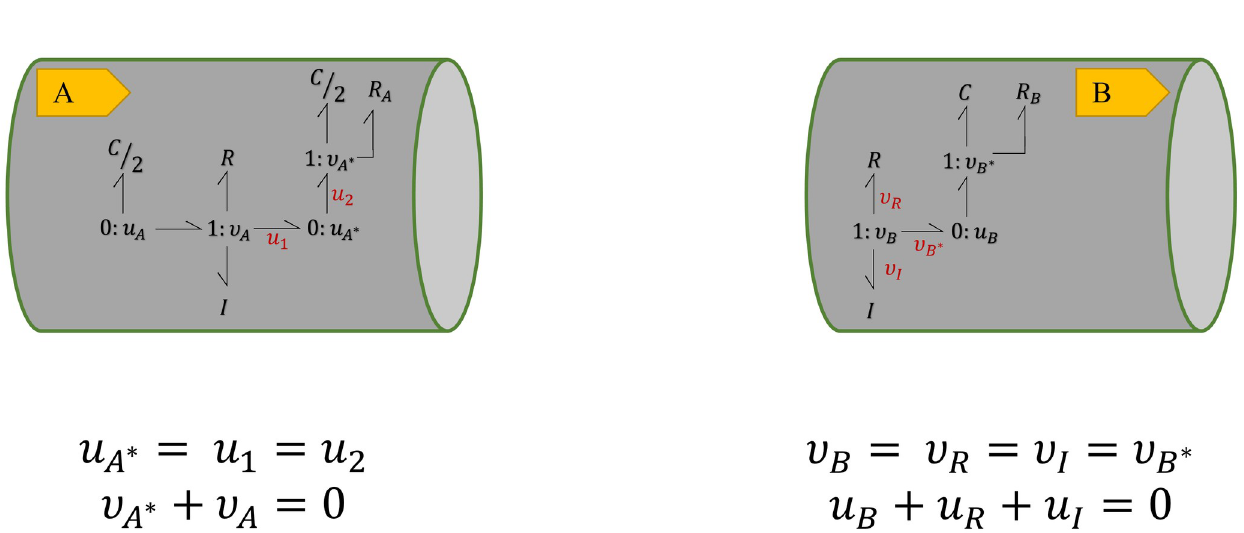
Fig 4. Conservation equations at the terminal junctions in two bond graph modules. Equal flows at 1 : v junction and equal potentials at 0 : u junction. The sum of potentials equals to the inward potential in the 1 : v junctions and the sum of flows equals to the outward flow in the 0 : u junctions.